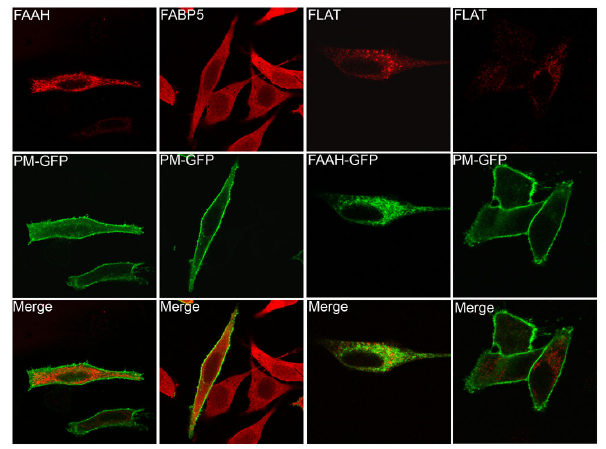
Figure 4. Localization of FLAT in HeLa cells. Subcellular distribution of FAAH, FLAT, and FABP5 in cells. FAAH and FLAT do not co-localize with the plasma membrane marker PM-GFP while FABP5 does. In contrast, FAAH and FLAT are distributed on intracellular